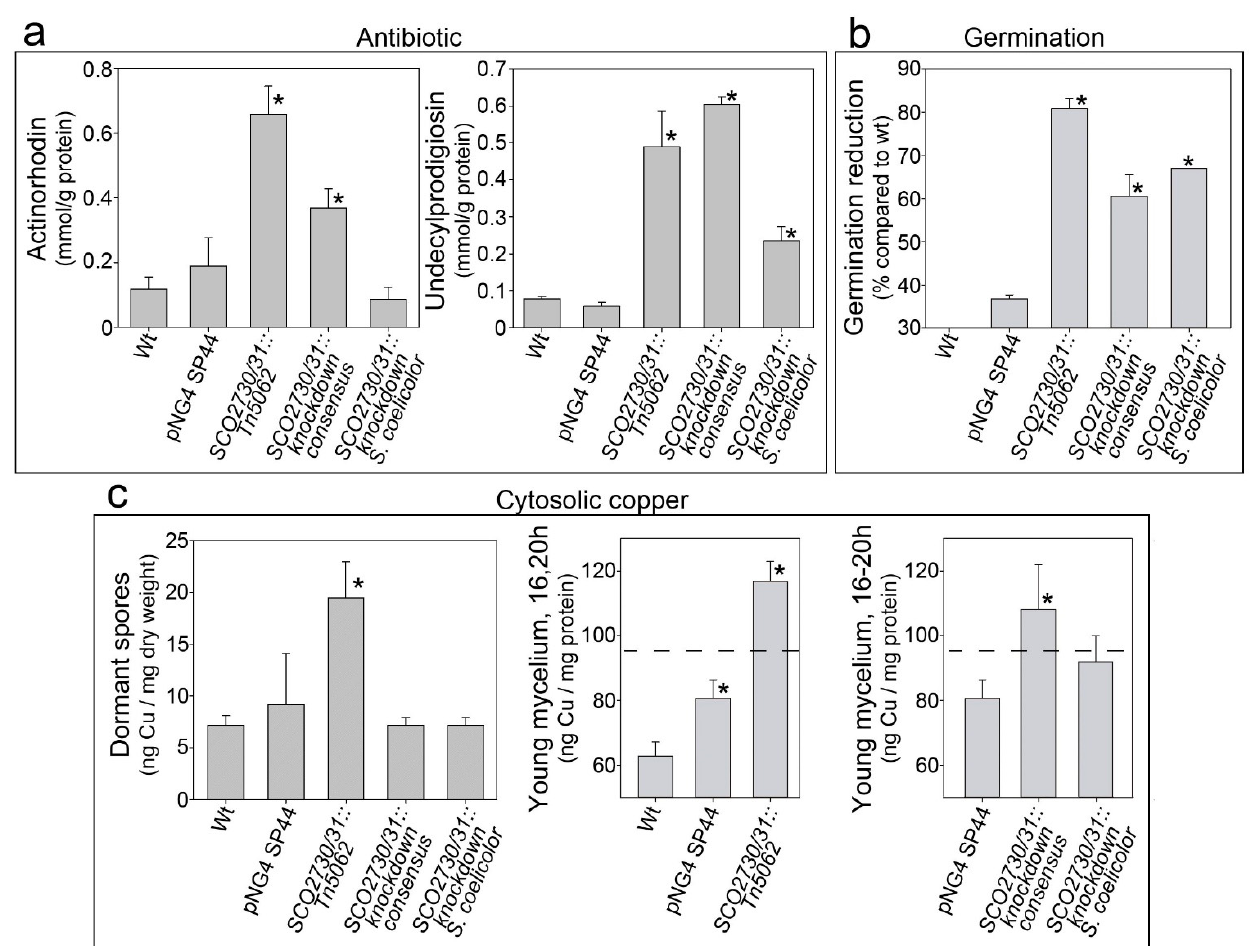
Figure 2. Antibiotic production, germination and cytosolic copper concentration in the S. coelicolor SCO2730/31 knockdown mutants compared to the wild-type strain with and without the pNG4-SP44 plasmid and the SCO2730::Tn5062 mutant. ( a ) Maximum actinorhodin and undecylprodigiosin production (145 h sucrose-free R5A liquid cultures). ( b ) Percentage of germination reduction compared to the wild-type strain (8 h GYM solid cultures). ( c ) Cytosolic copper in dormant spores (left panel, SFM cultures) and young mycelium (16–20 h sucrose-free R5A liquid cultures) (middle and right panels). The dashed line indicates the cytosolic copper umbral triggering secondary metabolism [13]. The asterisks indicate significant differences compared to the wild-type strain or the wild-type strain harbouring the pNG4-SP44 plasmid ( p value equal to or less than 0.05).